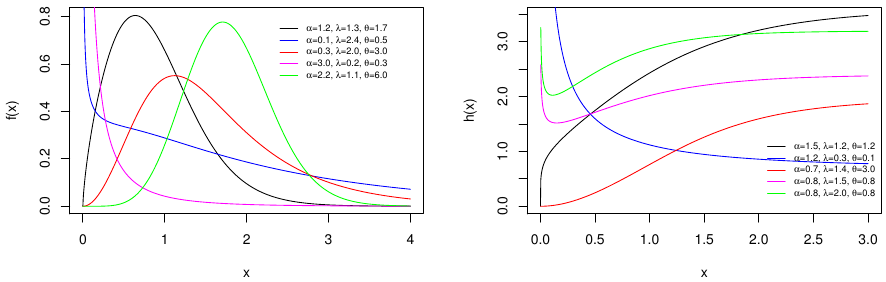
Figure 4. Plots of the pdf and hrf of the ECSGHL distribution for some parameter